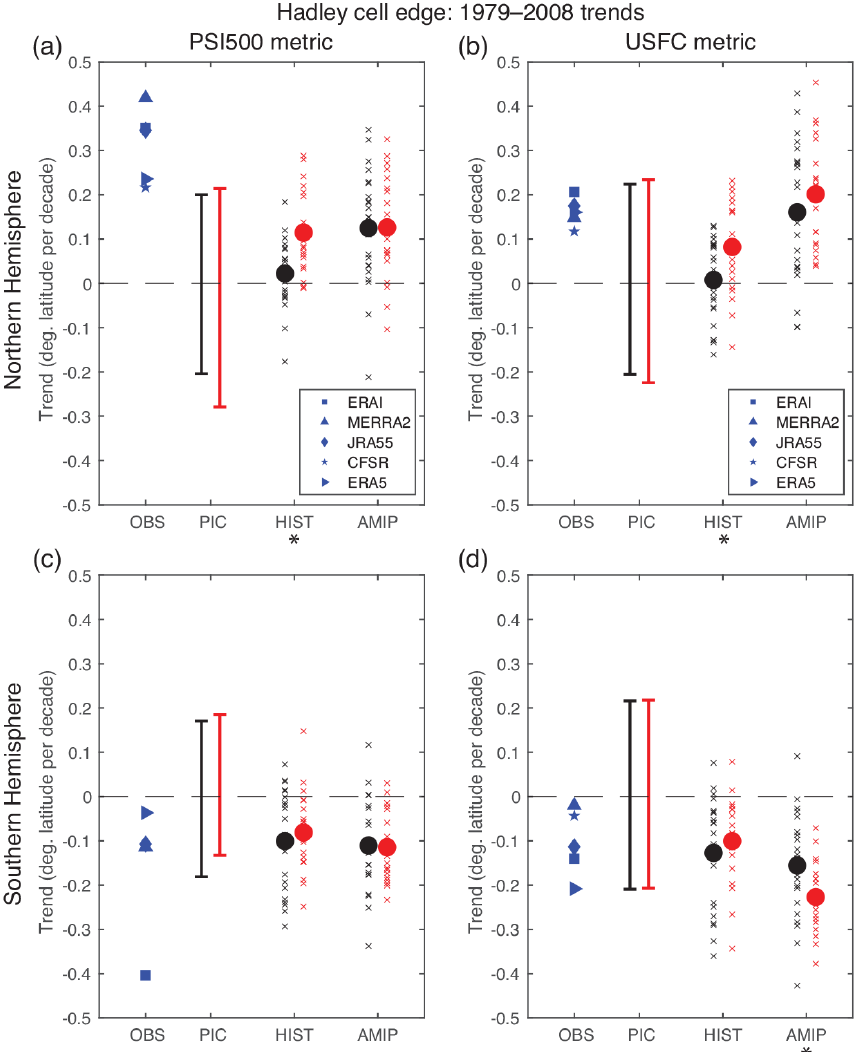
Figure 4. The 1979–2008 trends in annual-mean Hadley cell edge latitude, as measured by the (a, c) PSI500 and (b, d) USFC metrics. Reanalysis trends (OBS, blue symbols) are taken from the ERA-Interim (ERAI), MERRA-2, JRA-55, CFSR, and ERA5 reanalyses. Because MERRA-2 begins in 1980, trends for MERRA-2 are shown for 1980–2008. Control trends (PIC) show the 2.5th–97.5th percentile of trends over 30-year periods from the pre-industrial control runs of (black) CMIP5 and (red) CMIP6 models. Historical trends (HIST) and AMIP trends are calculated from the first ensemble members of (black) CMIP5 and (red) CMIP6 models, where the response of each model is shown with a small “x” and the multi-model mean response is shown as a large dot. Because the historical runs of CMIP5 models end in 2005, they are extended with 3 years of the RCP 8.5 run until 2008. Asterisks denote where multi-model means of CMIP5 and CMIP6 models are statistically different at the 95% confidence level via Student’s t